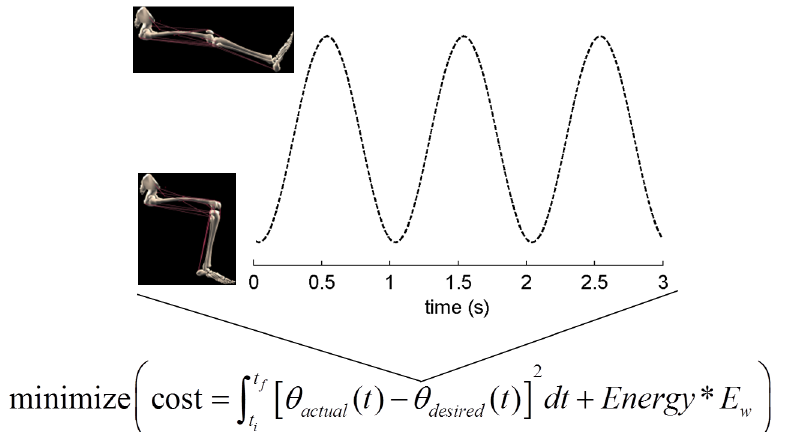
Fig 2. Quantitative definition of the task. The task was defined as minimizing a combination of kinematic error and energetic cost. Kinematic error was a function of the deviation of knee angle from an idealized trajectory ( θ desired ) derived from Andersen et al. [21]. Energetic cost was the rate of metabolic energy consumption of all muscles, averaged over the duration of the exercise. The relative weight of the kinematic and energetic terms (E w ) was determined such that the optimization algorithm converged reliably to solutions with kinematics within experimental variability at the lowest possible metabolic energy consumption. Graphic of musculoskeletal model is a screenshot of the model we constructed in open-source software named MusculoSkeletal Modeling Software (MSMS; [27]).